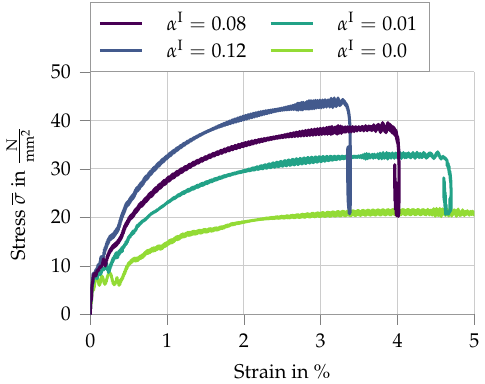
Figure 14. Analysis of the variation of the parameter α I from 0 to